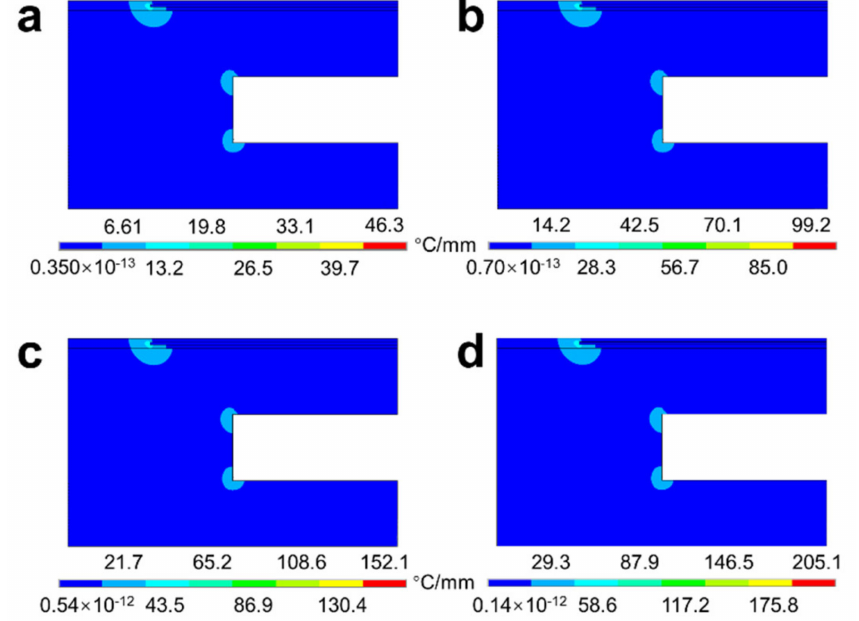
Figure 4. Temperature gradients at cross–sections of the nitrogen–oxygen sensors at different heating temperatures: ( a ) 200; ( b ) 400; ( c ) 600; ( d ) 800 ◦